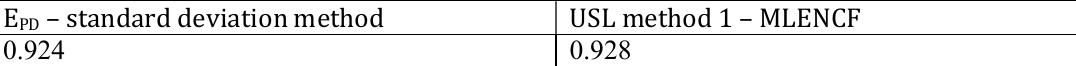
Table IV.: E and USL Methods using 13 Experimental PD